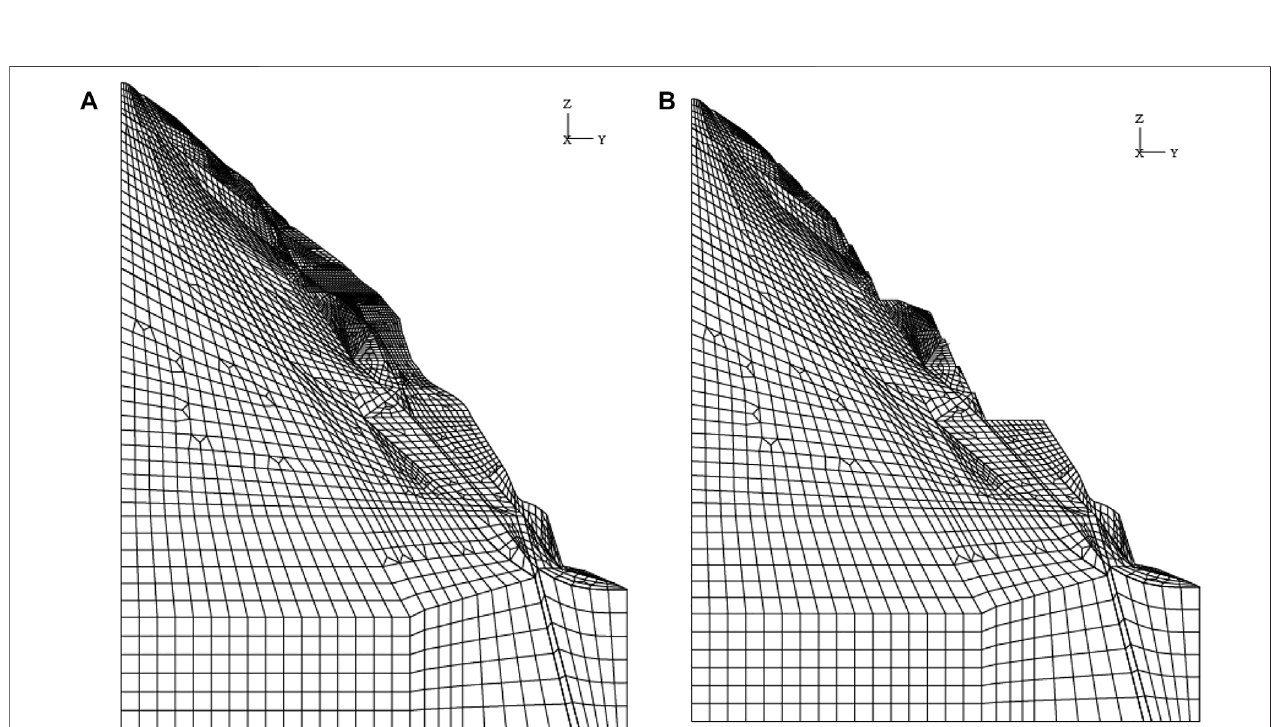
FIGURE 6 | (A) Slope ’ s fi nite element model before excavation. (B) Slope ’ s fi nite element model after excavation.